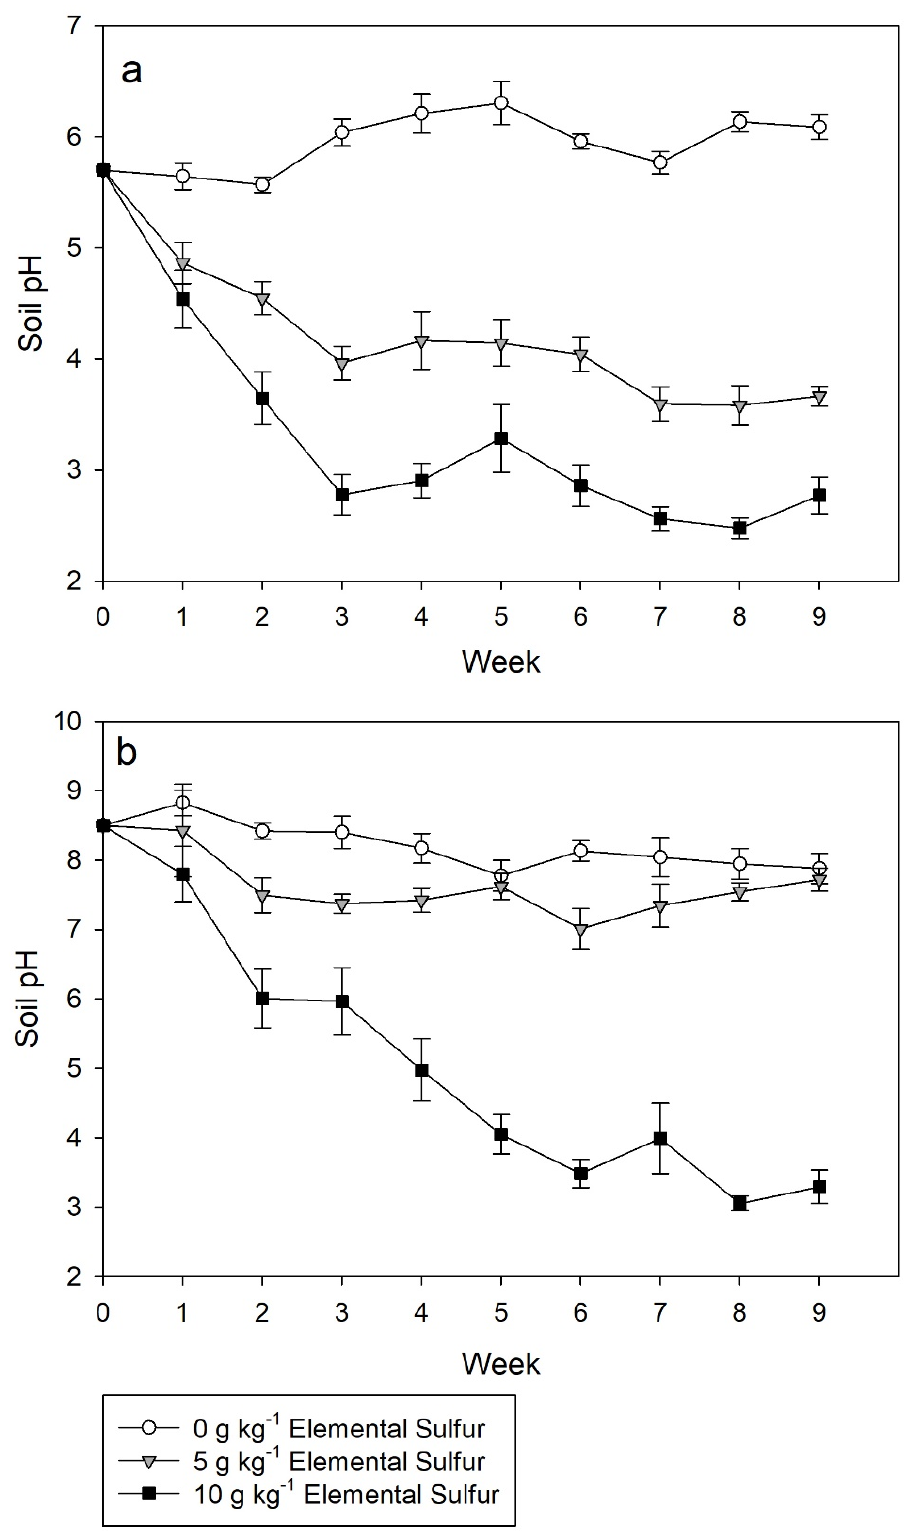
Figure 1. Changes of soil pH following the addition of 0, 5, and 25 g kg − 1 elemental sulfur to soil